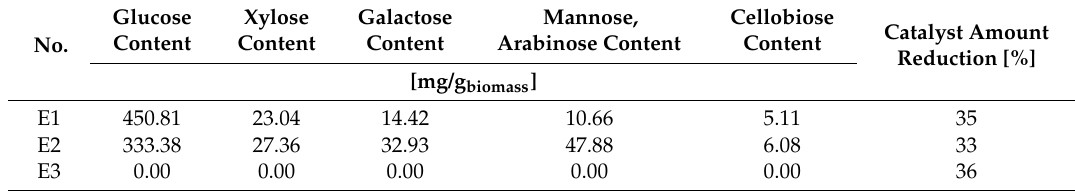
Table 8. Content of monosugars in hydrolysates after the enzyme’s